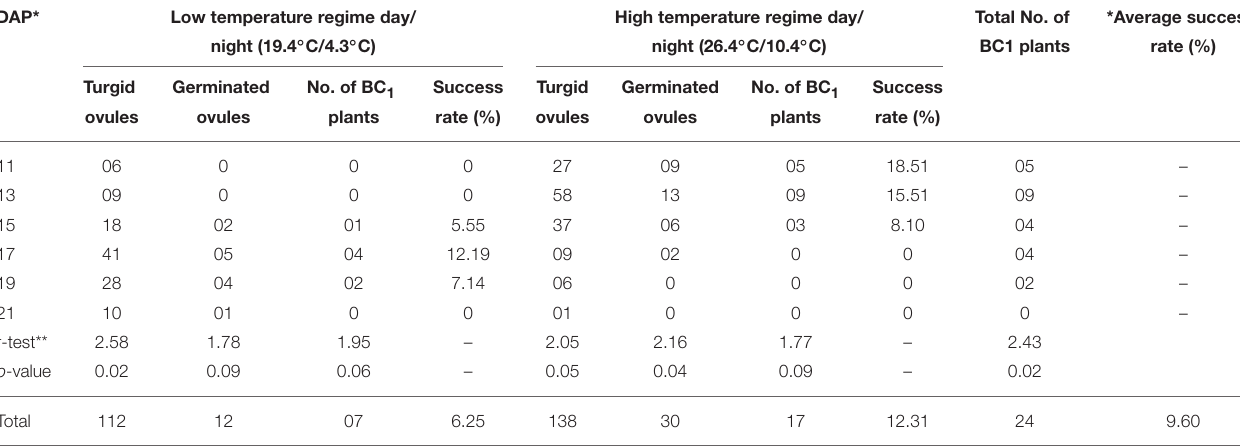
TABLE 2 | Production of BC 1 plants using direct ovule culture under two different temperature regimes. DAP* Low temperature regime day/ High temperature regime day/ Total No. of *Average success night (19.4 ◦ C/4.3 ◦ C) night (26.4 ◦ C/10.4 ◦ C) BC1 plants rate (%) Turgid Germinated No. of BC